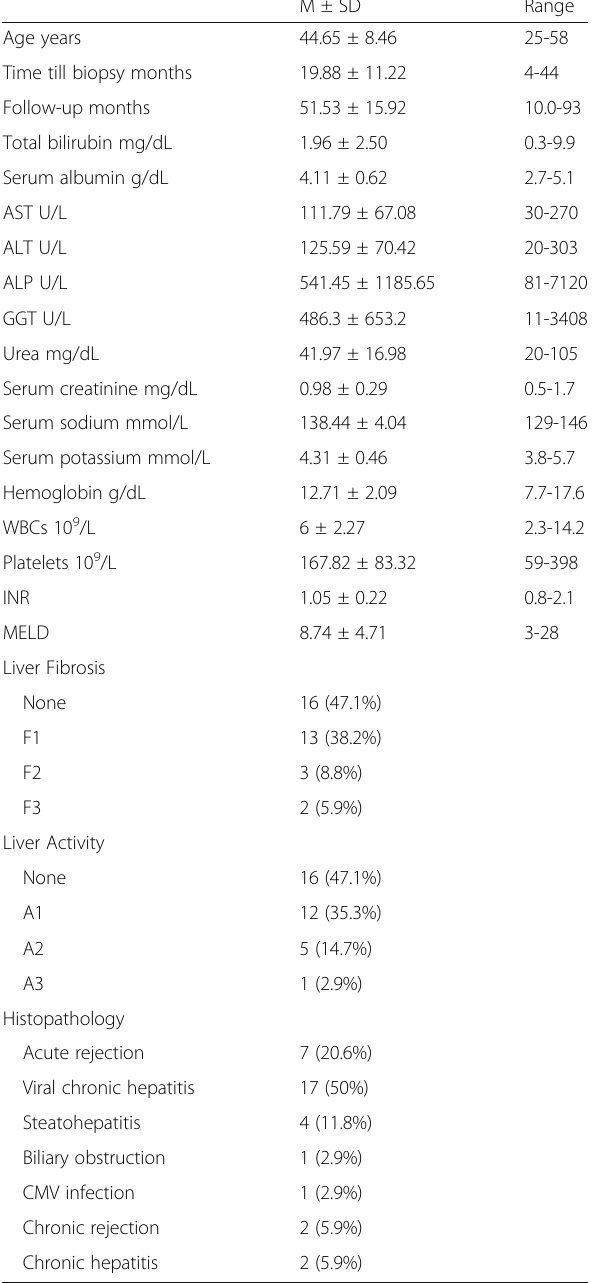
Table 1 Characteristics of the liver transplant recipients that were